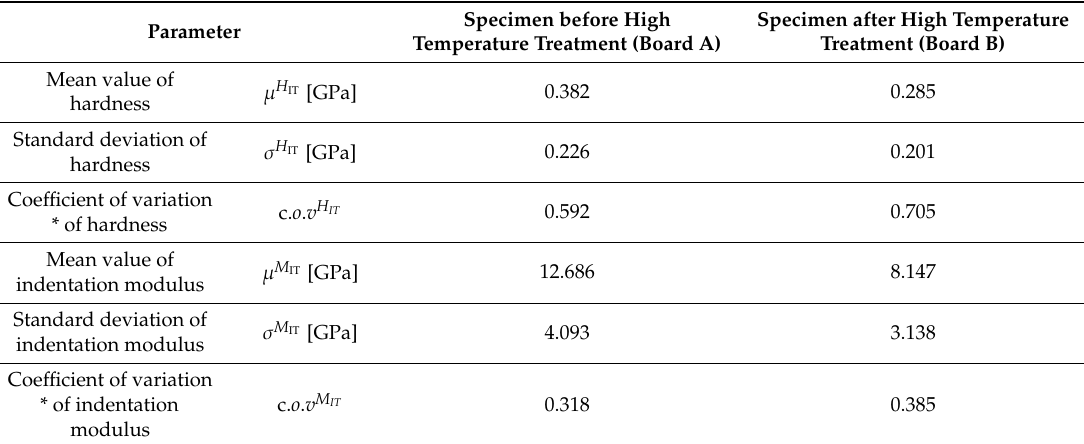
Figure 12. ( a ) Histograms of hardness; ( b ) histograms of indentation modulus. Table 2. Summary of nanoindentation results.